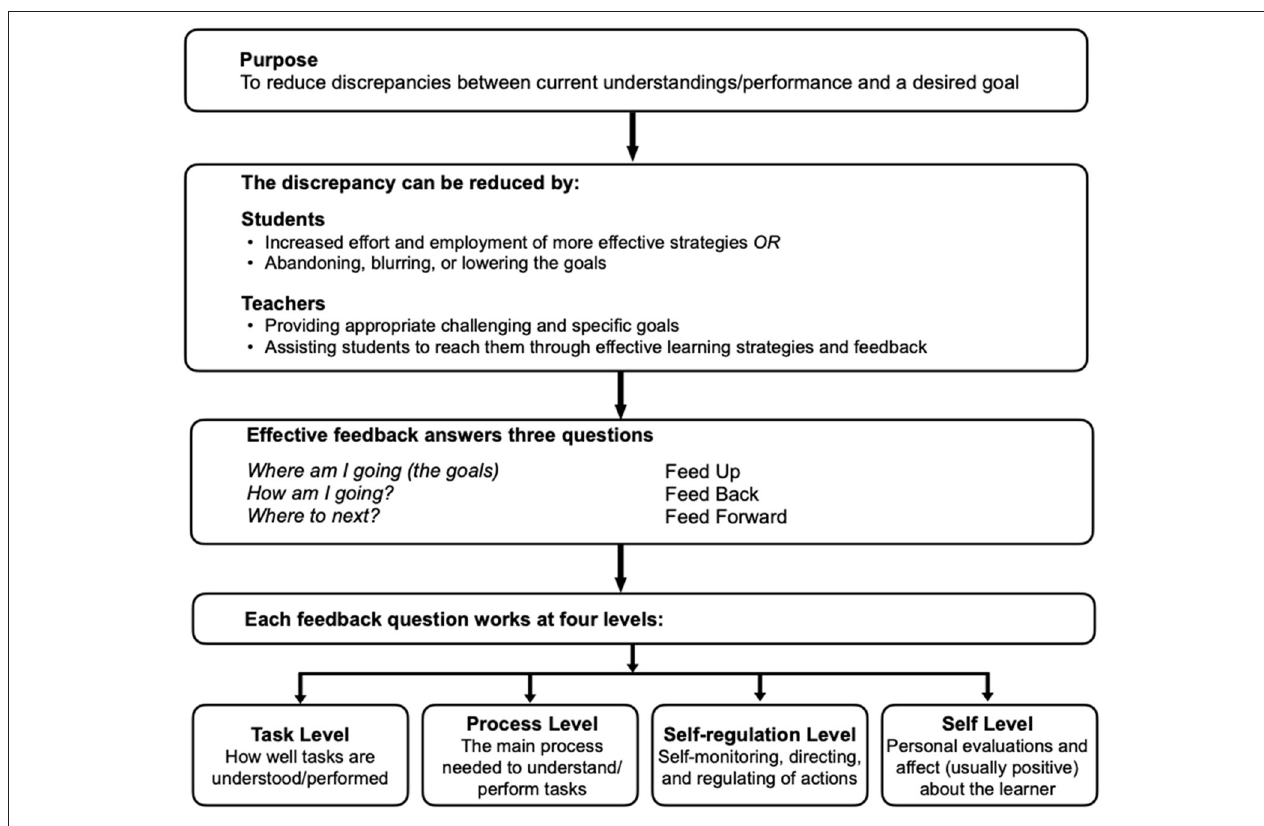
FIGURE 2 | A model of feedback to enhance learning. Reprinted with permission from Hattie and Timperley (2007, p.